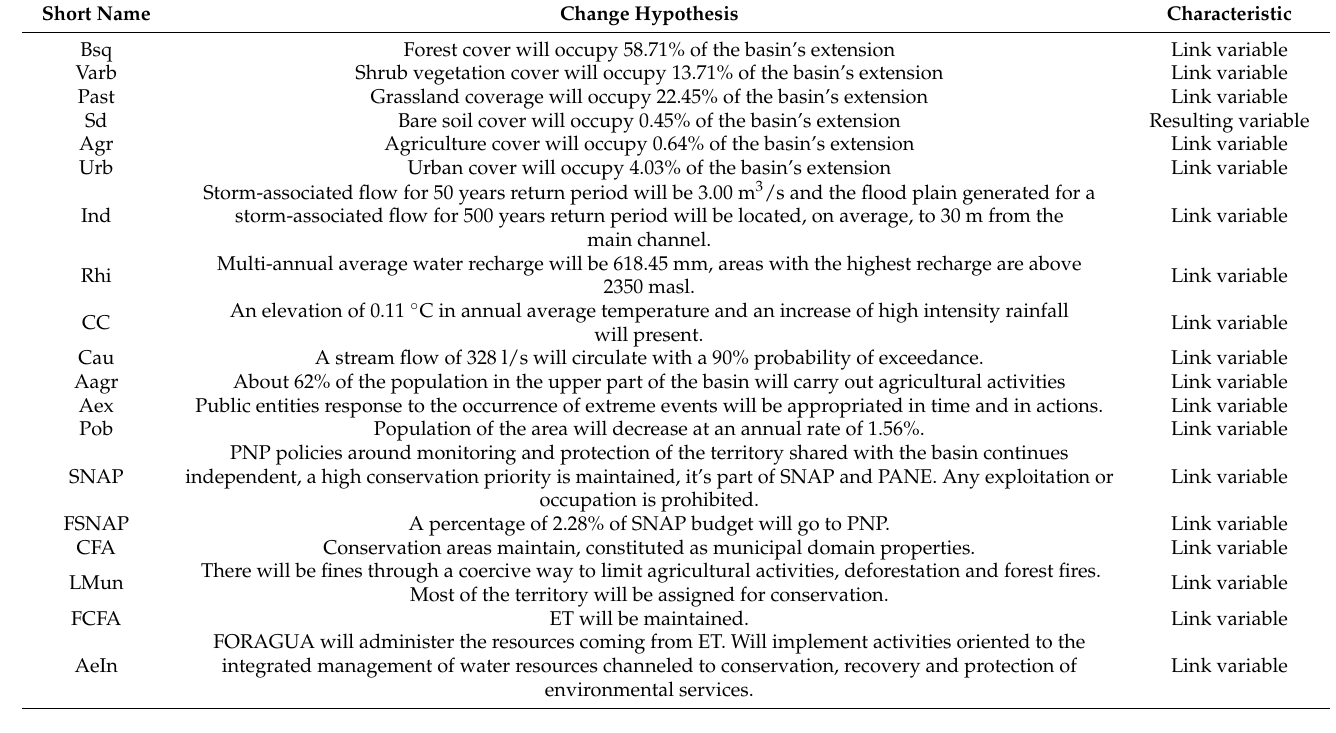
Table 4. Trending future change scenario, hypothesis by variable, and its